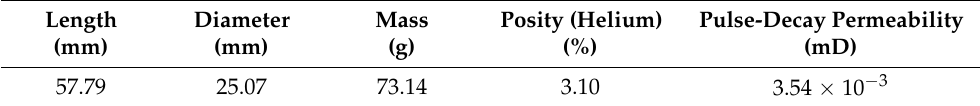
Table 1. Basic parameters of the saturated–gas producing experimental samples.